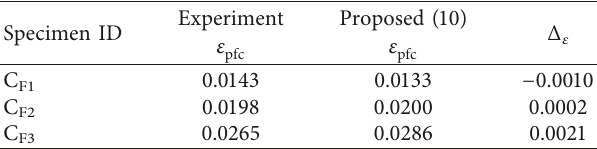
Table 6: Comparison of strains at peak stresses between the proposed and experimental results.